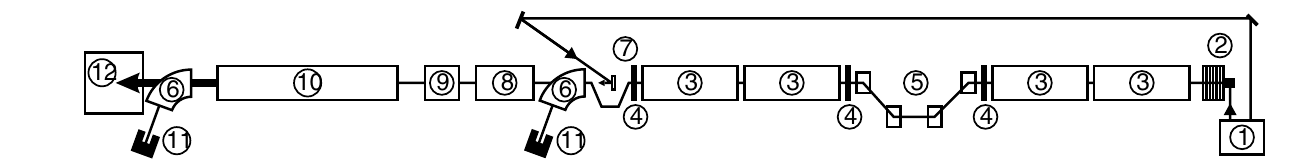
FIG. 1. The National Synchrotron Light Source DUV-FEL layout: 1: gun and seed laser system, 2: rf gun, 3: linac tanks, 4: focusing triplets, 5: magnetic chicane, 6: spectrometer dipoles, 7: seed laser mirror, 8: modulator, 9: dispersive section, 10: radiator (NISUS), 11: beam dumps, 12: FEL measurement